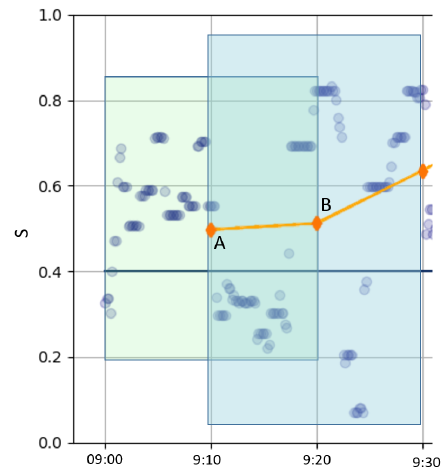
Figure 8. Moving-average filter example. Diamond A represents the average of S from 9:00 to 9:20 and diamond B represents the average of S from 9:10 to 9:30.